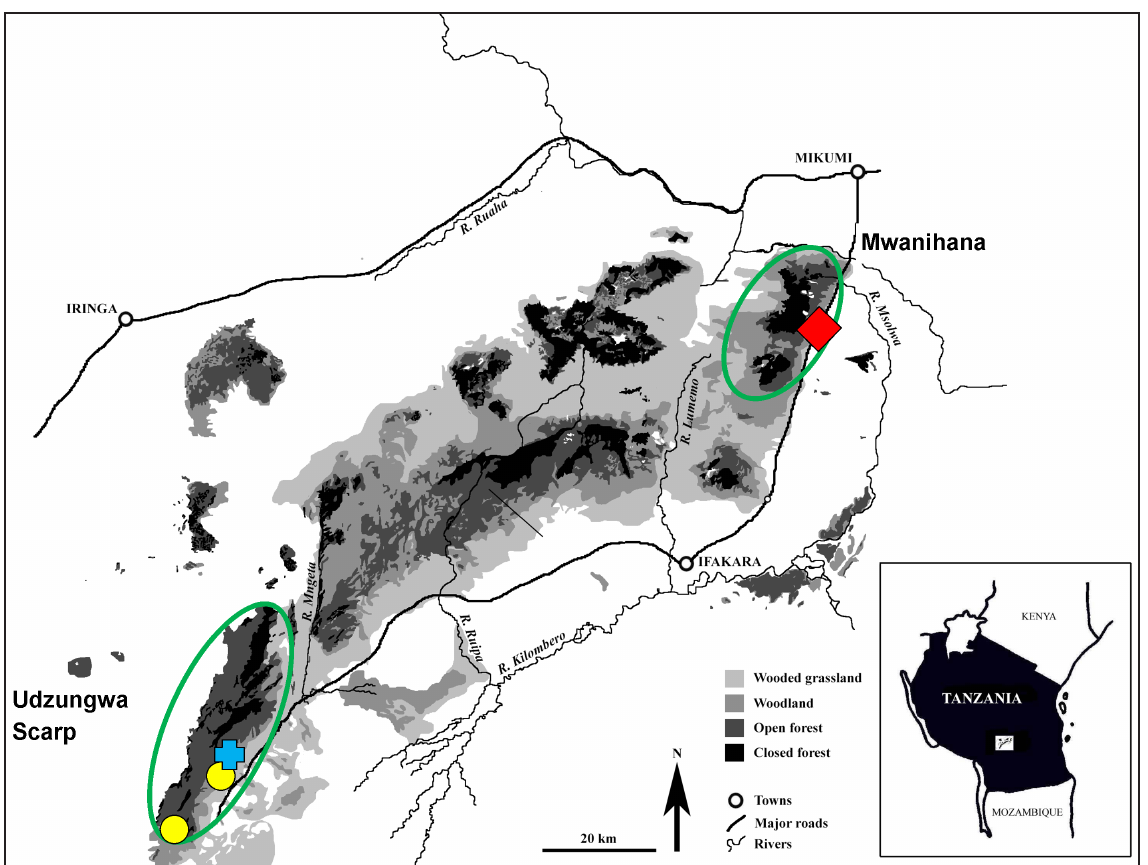
Fig. 1. Map of the Udzungwa Mountains, showing the collecting localities for Casuariverpa scarpa gen. et sp. nov. (yellow dots), Yia geminispina gen. et sp. nov. (blue cross), and Utiliverpa decapsulatrix sp. nov. (red diamond). Based on fig. 1 in Marshall et al .